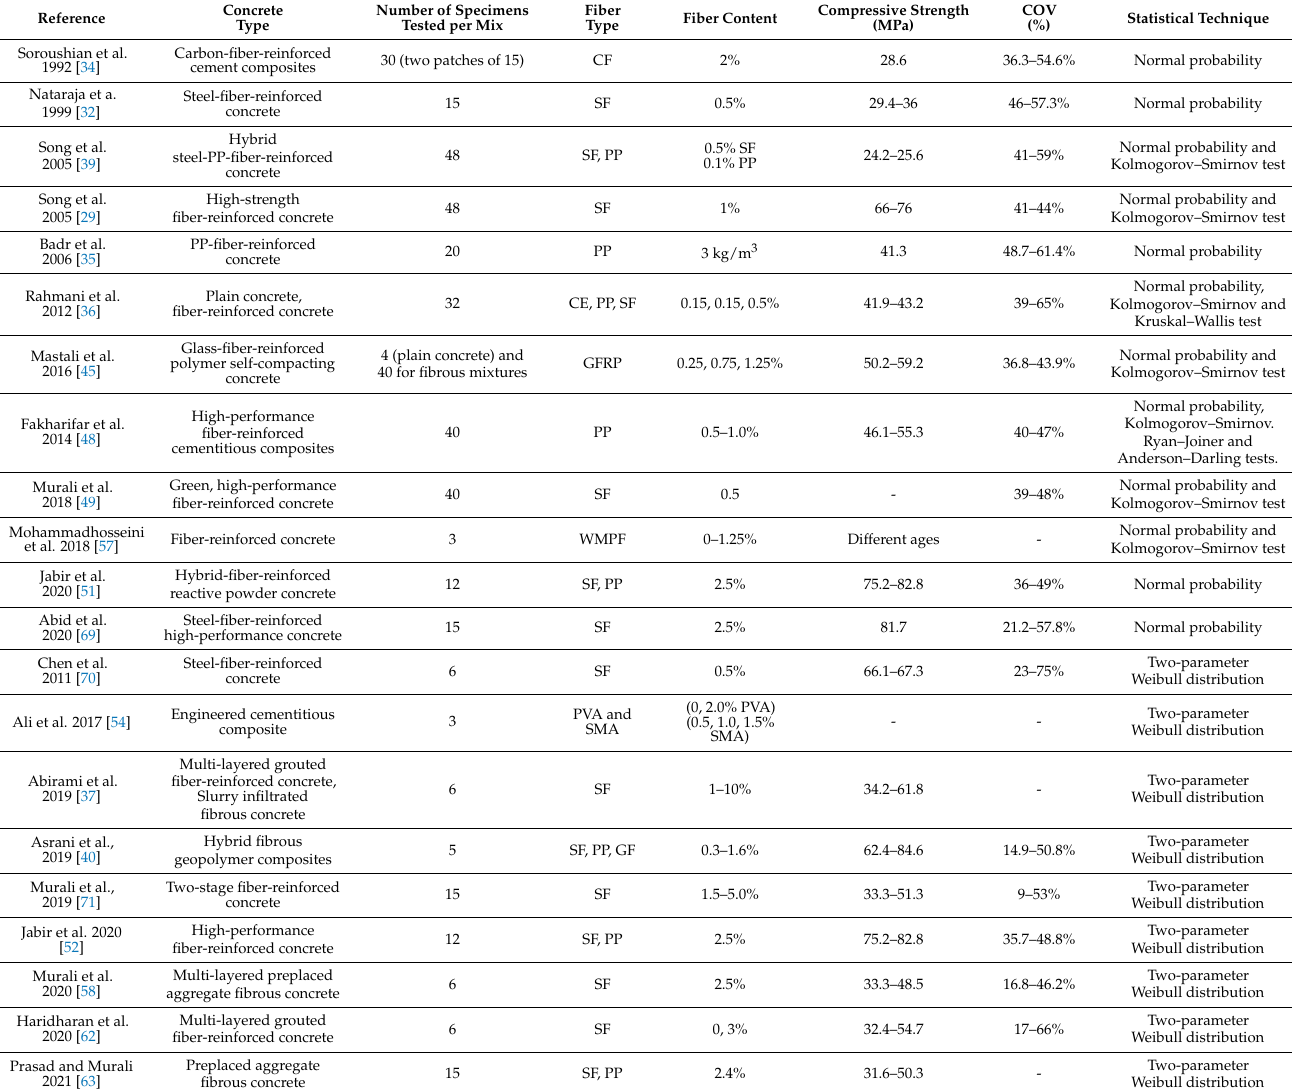
Table 1. Statistical evaluation tools of impact cracking and failure numbers in the